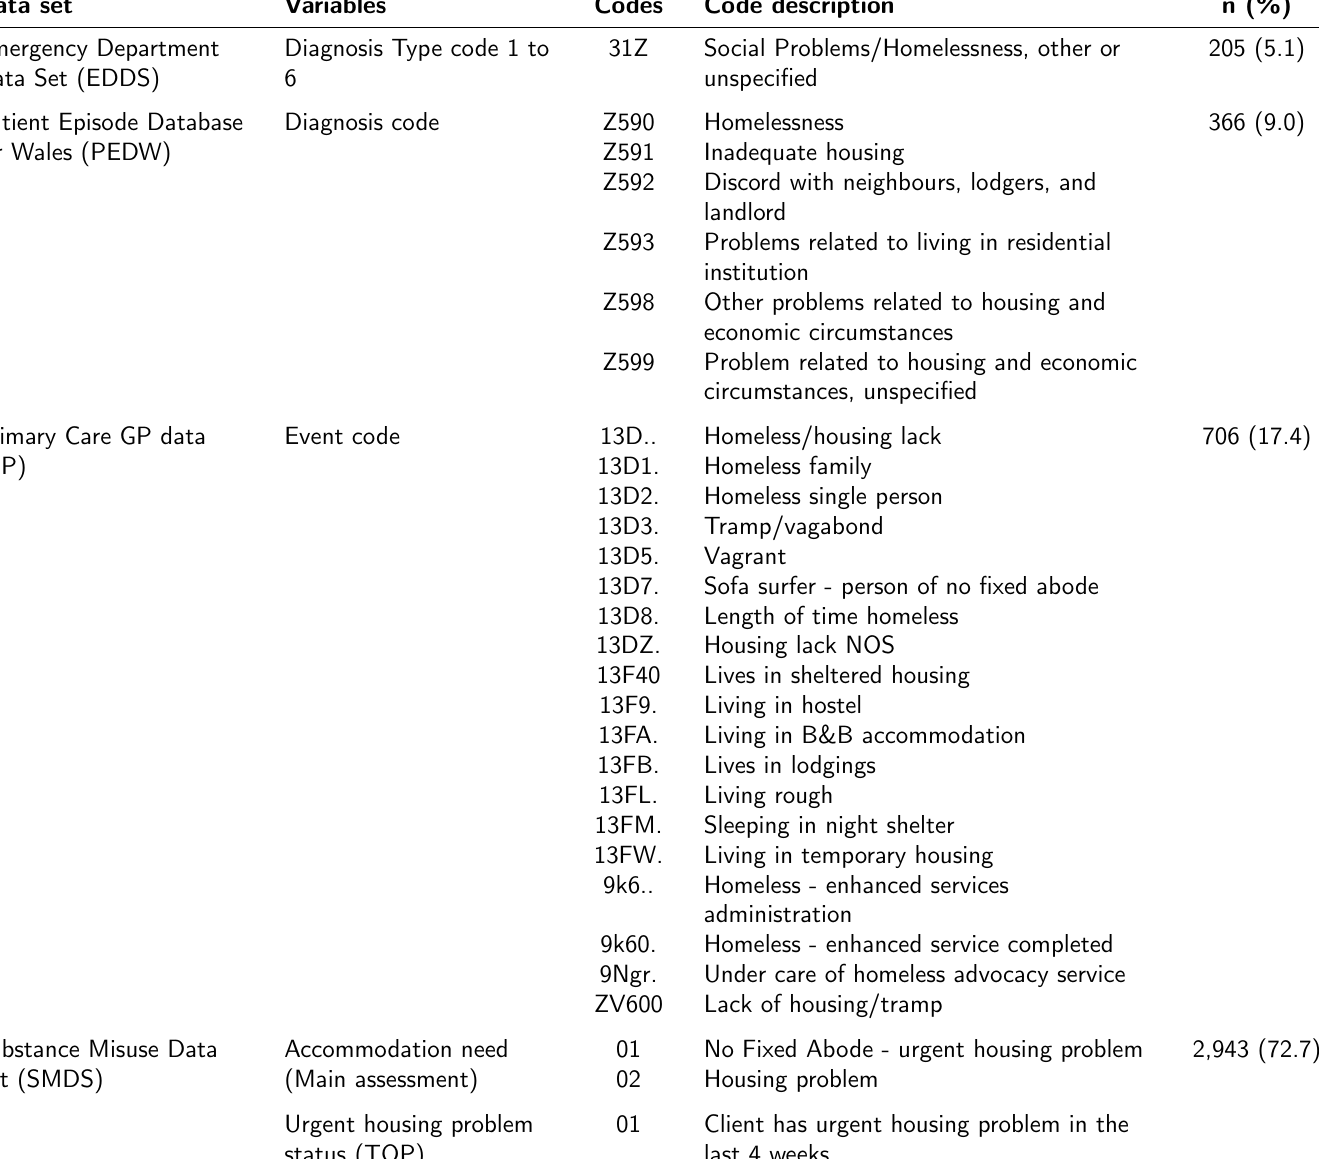
Table 1: Variables and codes used to identify homelessness events, and initial number of people identified within each data set as experiencing homelessness (% of total number of unique people, N =